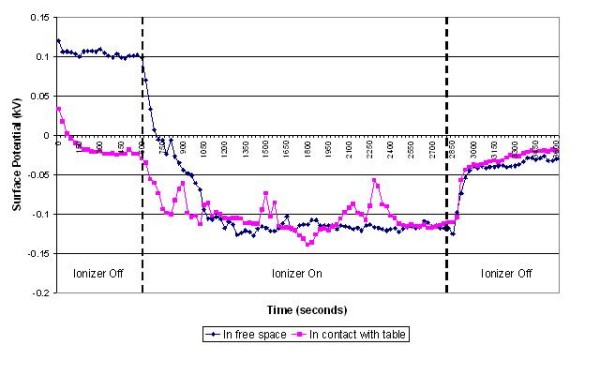
Change in surface potential over time for the face mask in the presence of negative air ions.